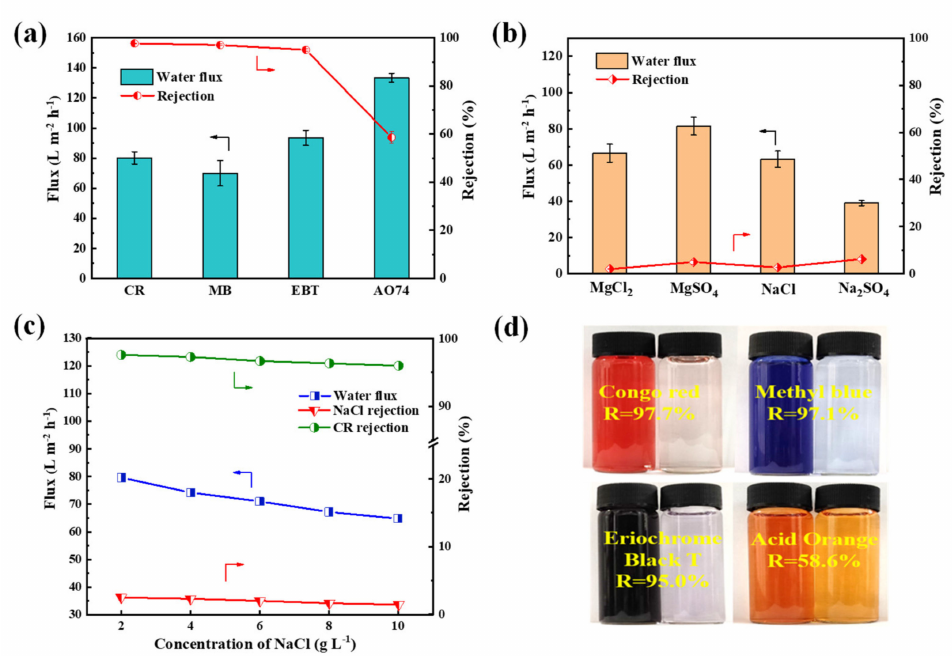
Figure 7. ( a ) Filtration performance of single dye solution, ( b ) rejections of salts, ( c ) filtration perfor- mance for the dye/salt mixture solution for the PES/Fe-TA3h membrane and ( d ) photographs of feed and penetration